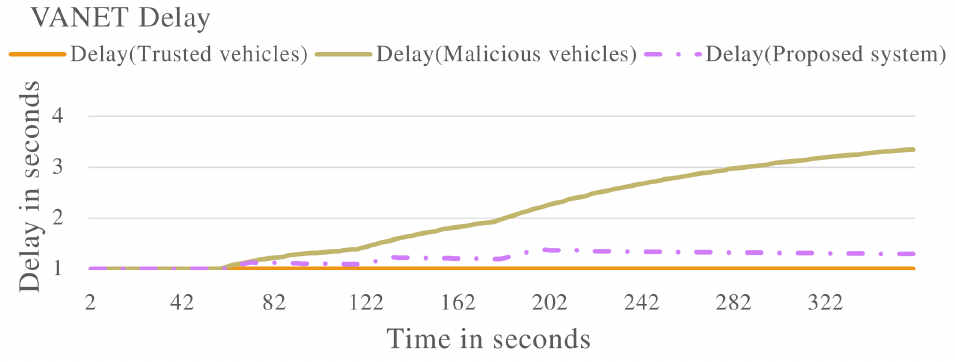
Figure 9. VANET delay multiple scenarios including vehicles that are delaying packets in the VANET.